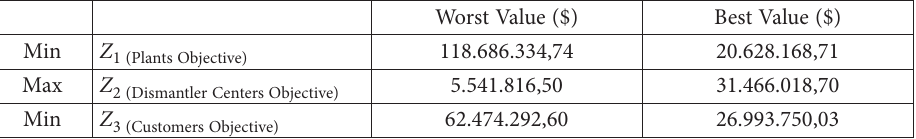
Table 3. The worst and the best values of objective functions relates to the problem Worst Value ($) Best Value ($) 118.686.334,74 20.628.168,71